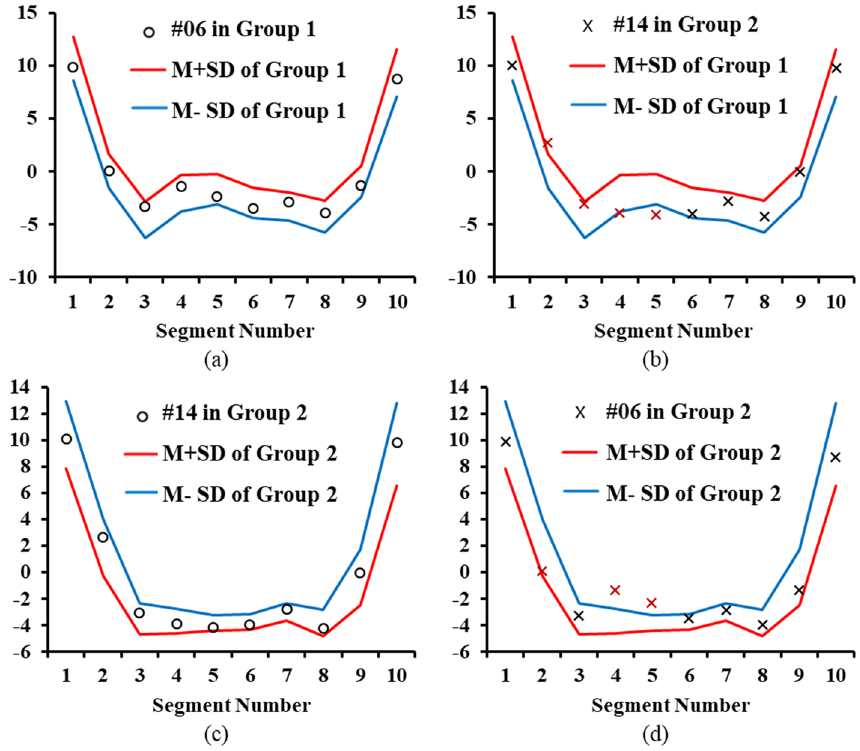
Figure 3. Example group identification data of subjects #6 and #14; ( a ) comparing subject #6’s normalized data in Group 1 with the reference data of Group 1, ( b ) comparing subject #14’s data in Group 2 with the reference data of Group 1, ( c ) comparing subject #14’s data with the reference data of Group 2 and ( d ) comparing subject #6’s data with the reference data of Group 2.